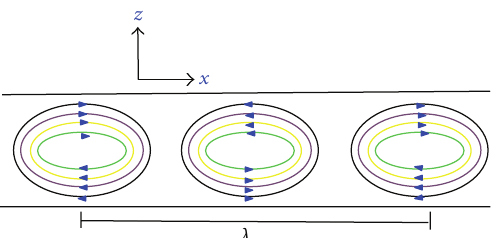
Figure 2: Projection of the magnetic component of the basic TE mode in the